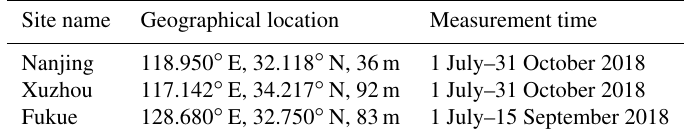
Table 2. MAX-DOAS measurement sites.